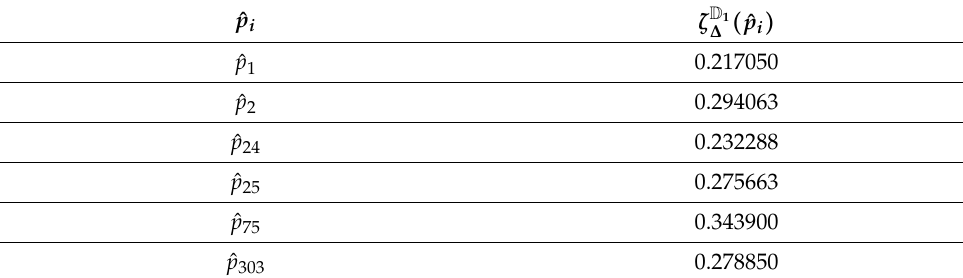
Table 8. Fuzzy membership ζ